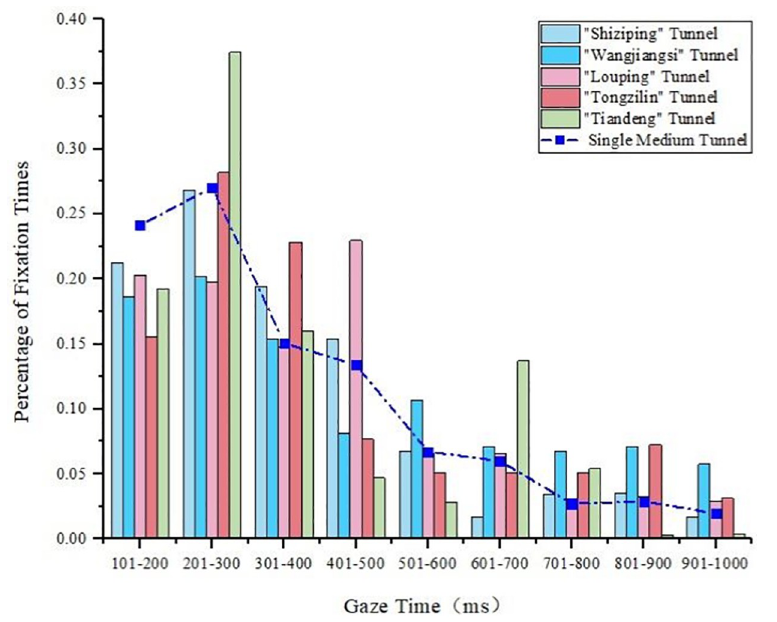
Fig 4. Statistical diagram of the gaze time of the medium tunnels in the tunnel groups.